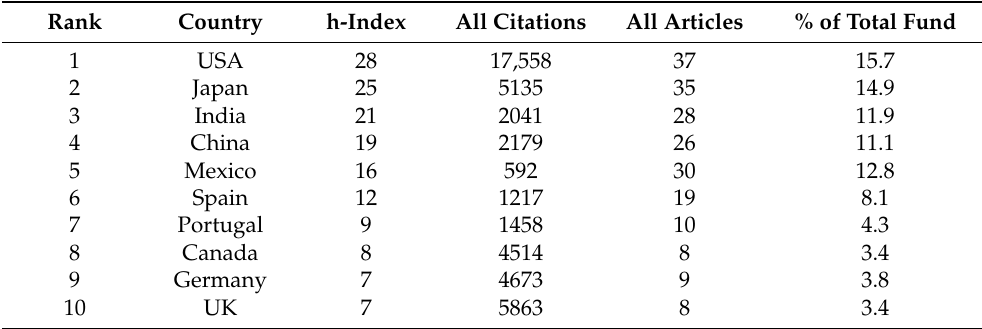
Figure 6. Top 10 authors’ productivity over the period of 1985–2021. The line represents an author’s timeline; the size of the bubbles is proportional to the number of documents produced by an author per year; the colour intensity of the bubble is proportional to the total number of citations per year; the first bubble on the line indicates when the author began to publish in the field; the bigger the bubble is, the higher the number of articles published by an author per year; bubbles with deeper colour intensity indicate higher citation counts. Table 6. Most influential countries that provided funds for FPBMs prepared by RIGC in the period of